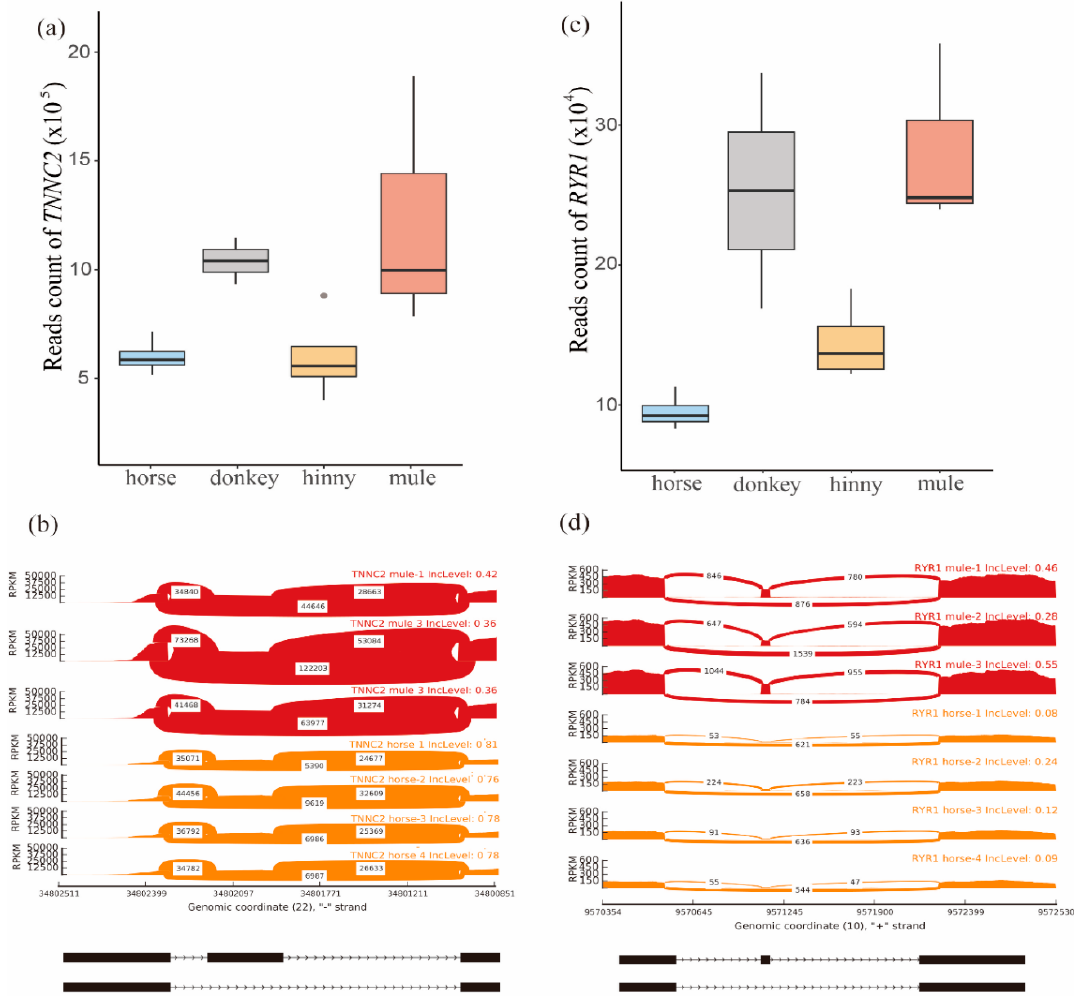
Figure 4. Analysis of TNNC2 and RYR1 genes. ( a ) Distribution of reads mapped on the TNNC2 gene in muscle tissue of mule, hinny, and their parents. ( b ) Sashimi plot of the TNNC2 gene showing DAS events in mule muscle tissue. ( c ) Distribution of reads mapped on the RYR1 gene in muscle tissues of mule, hinny, and their parents. ( d ) Sashimi plot of RYR1 gene showing DAS events in the mule muscle tissue. Read densities supporting inclusion and exclusion of exons are shown.